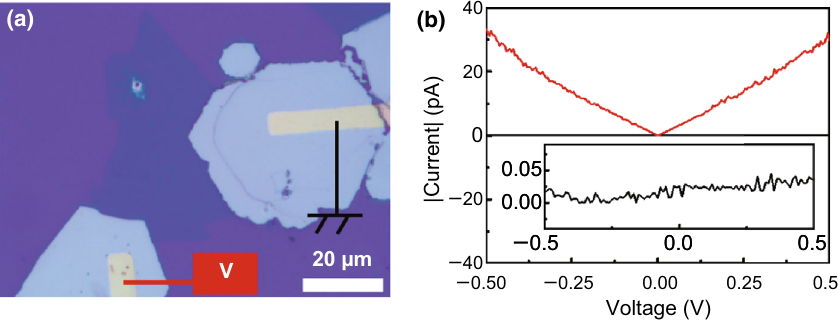
Fig. 3 a High-resolution TEM image of Mo 2 C, with space group Pbcn . b SAED pattern along the [ d High-resolution TEM image of MoS 2 , with space group P6 3 / mmc . e SAED pattern along the [0001] zone axis. f Raman spectrum of MoS 2